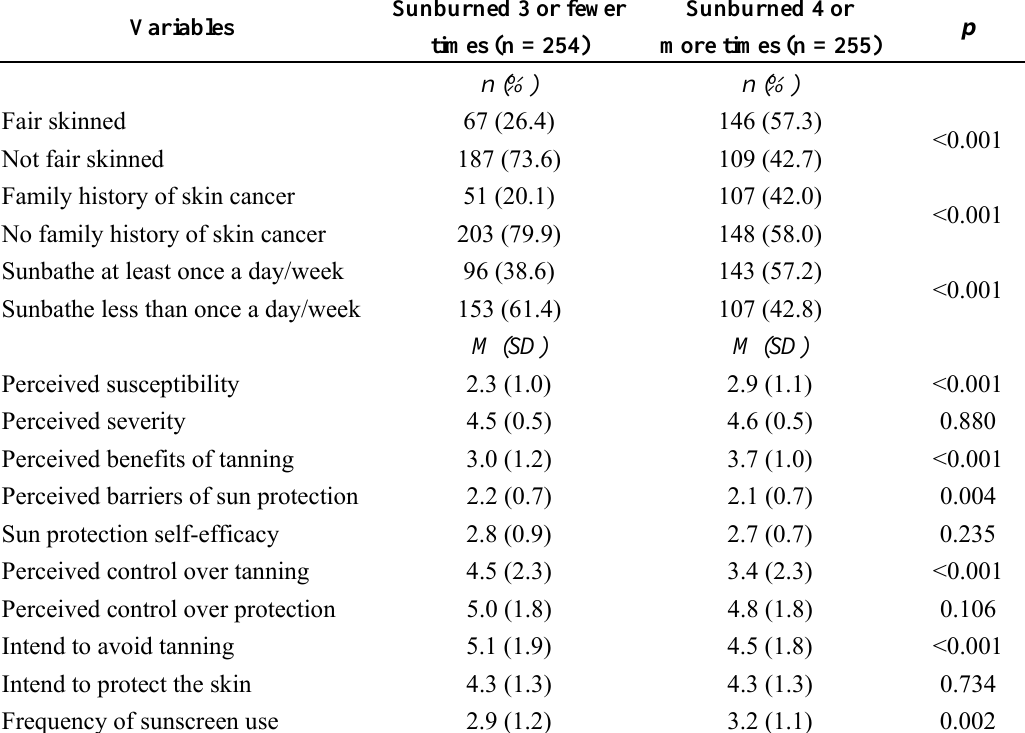
Table 1. Characteristics of college women by sunburn